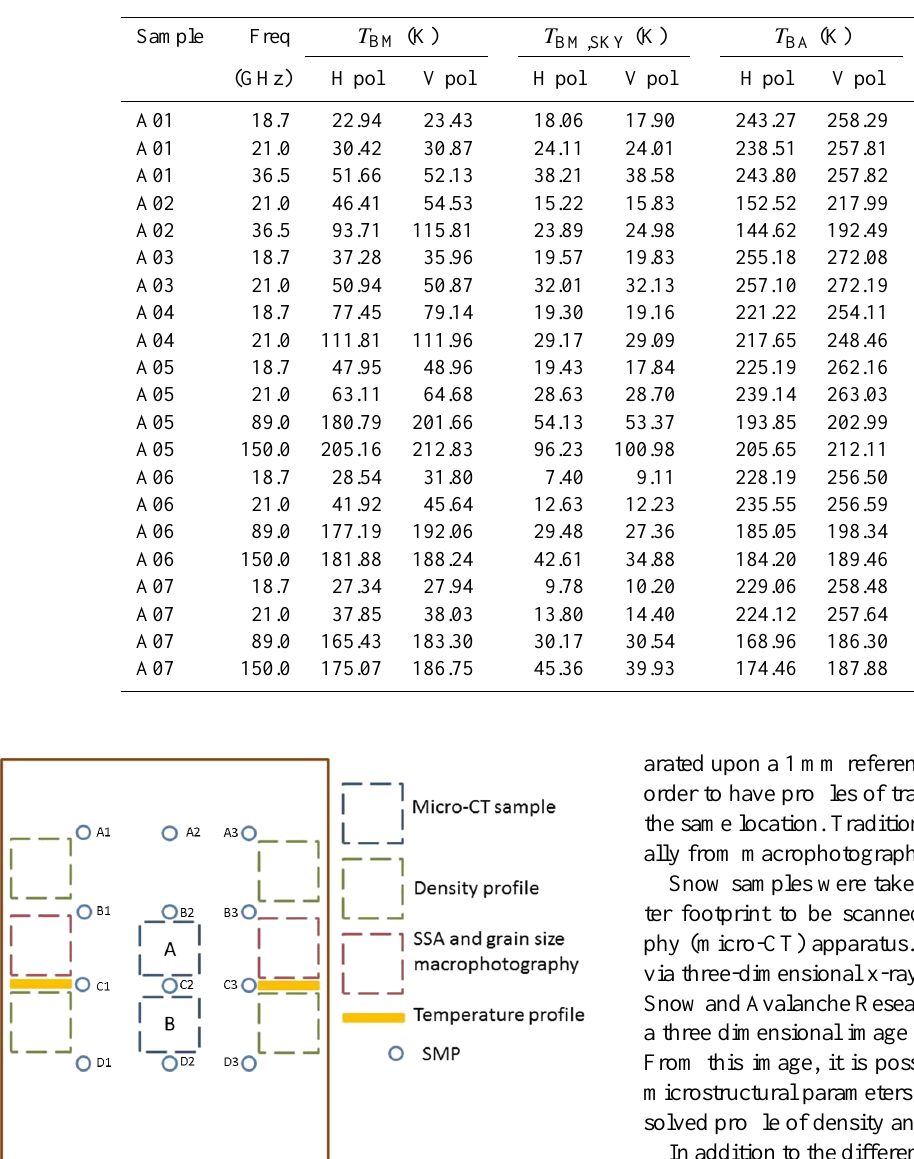
Table 1. Radiometric data measured from the 2014 ASMEx slabs. Brightness temperatures from reflective base ( T BM ), sky after reflective base measurements ( T BM,SKY ), absorbing base ( T BA ), and sky after absorbing base measurements ( T BA,SKY ) are presented. Horizontal (vertical) brightness temperatures are shown.